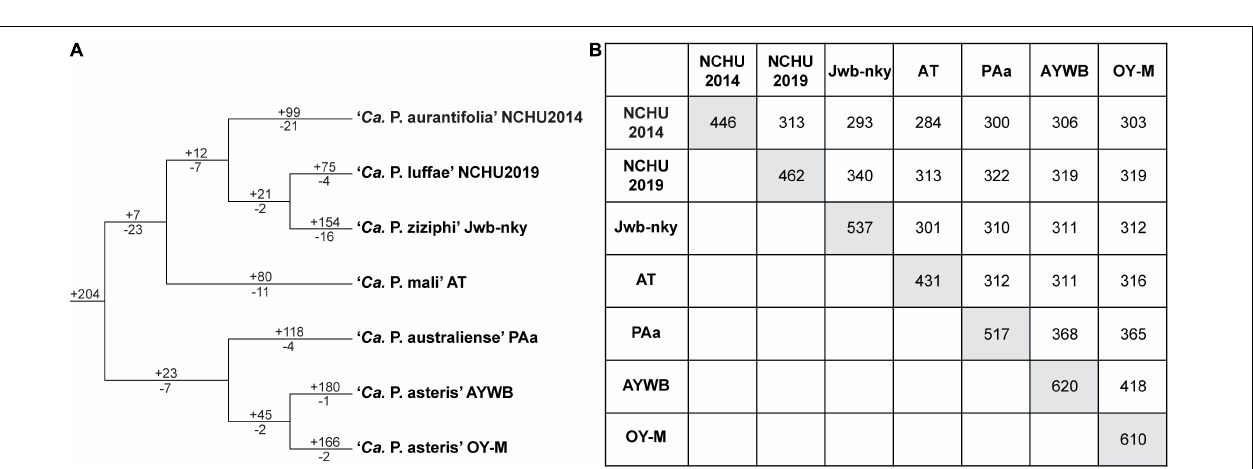
FIGURE 4 | Pairwise alignment of linearized genomes of ‘ Ca . P. aurantifolia’ strains NCHU2014 and NTU2011. (A) The complete genome of ‘ Ca . P. aurantifolia’ NCHU2014 was aligned with the draft genome of ‘ Ca . P. aurantifolia’ NTU2011. (B) Schematic diagram represented the inversion rearrangements indicated by red-dashed rectangles in (A) and the specific primers designed for PCR assays (left). The DNA fragments corresponding to the breakpoint of inverted structures in both chromosomal genomes were amplified (right). Primers: Phy588 (5 (cid:48) -GTTACTTTCGTGATTAATTCC-3 (cid:48) ), Phy589 (5 (cid:48) -GAATTTACAACAAGCTCAATTGG-3 (cid:48) ), Phy560 (5 (cid:48) -CTTGACTAATTTACTTTCGTCGC-3 (cid:48) ).